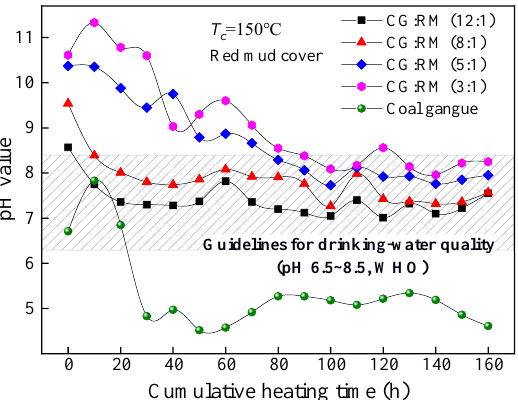
Figure 7. Variations of pH value of co-disposal leaching solution with different mass ratios.